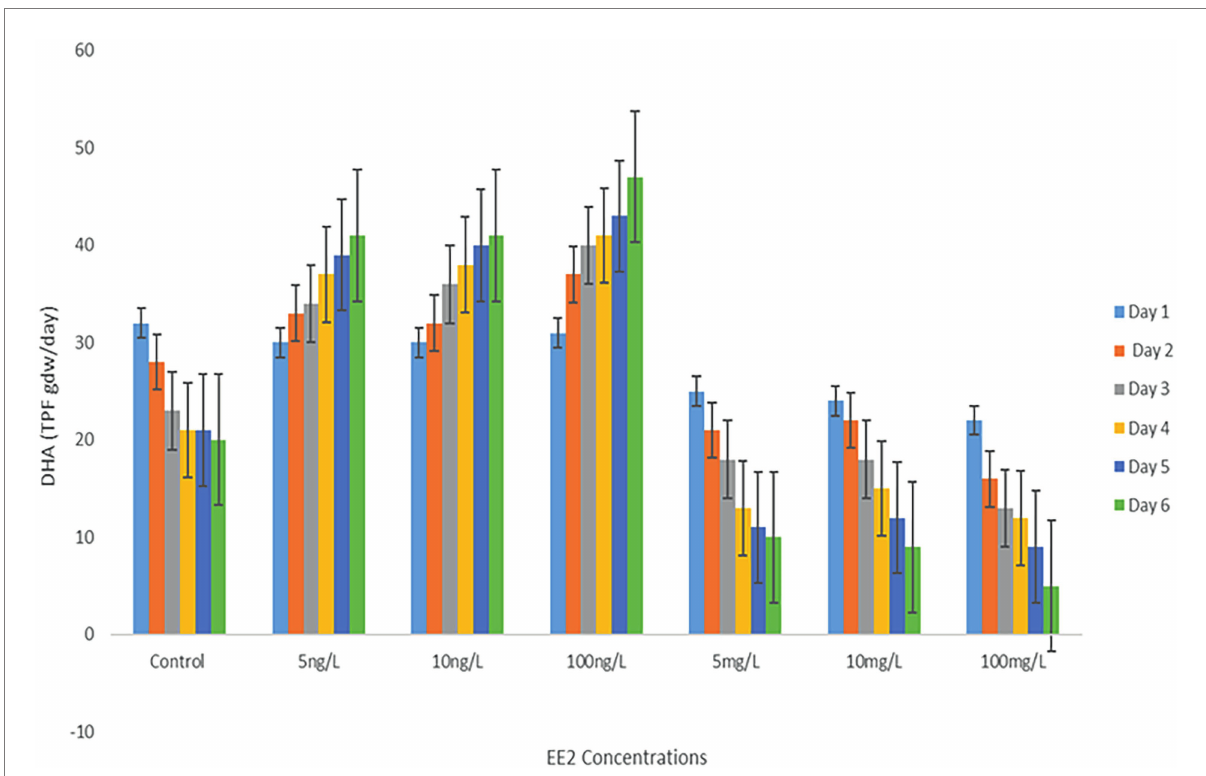
FIGURE 5 Comparison of DHA of AS treated with different concentrations of EE2 during a 6-day